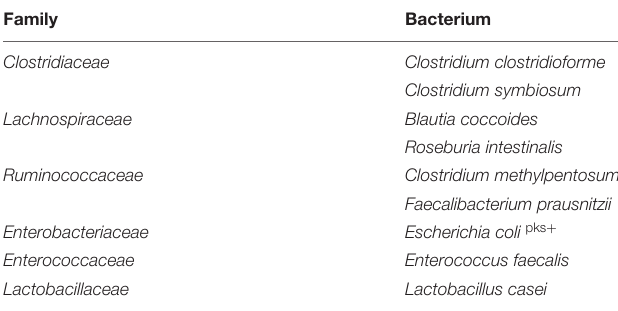
TABLE 1 | Representative isolates of bacterial